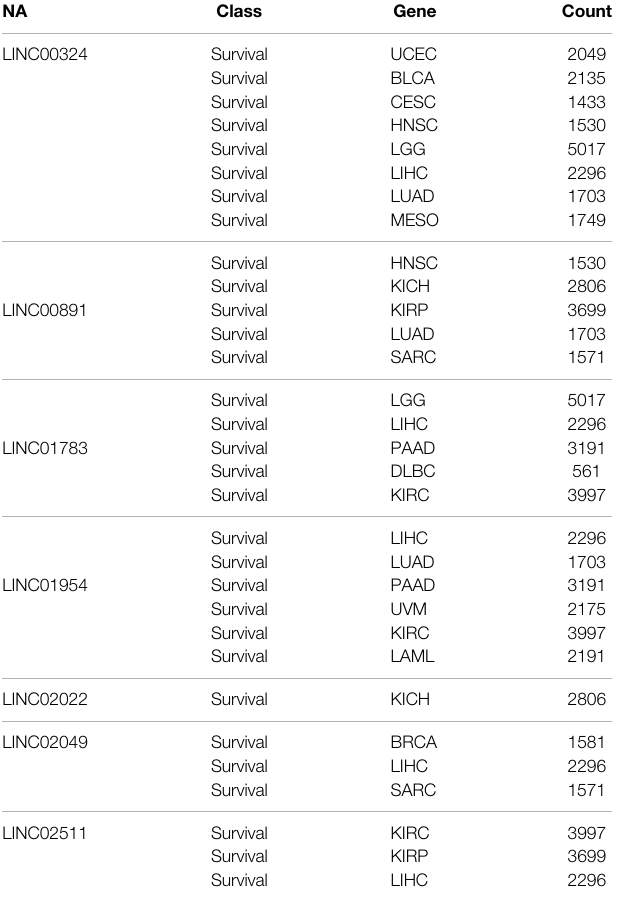
TABLE 1 | LncRNA related to prognosis using TCGA project. Differentially regulated lncRNAs in astronauts ’ exosomes at R+3 were further analyzed using the LncSEA database that integrates clinical data from The Cancer Genome Atlas project to screen for lncRNAs related to prognosis after univariate Cox regression analysis.